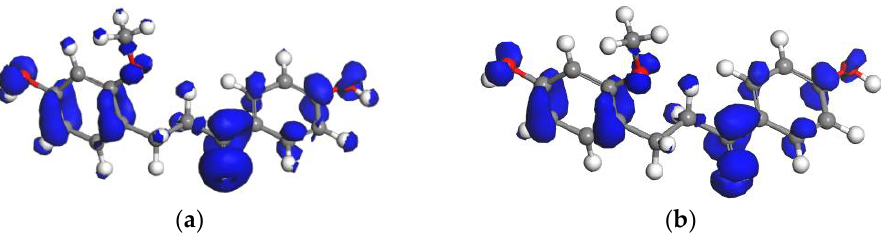
Figure 4. The Fukui function f 0 ( r ) of LC in gas phase ( a ) and in water ( b ) (mapped onto the isosurface of the total electron density, isovalue = 0.012507 a.u.). Table 2. The Fukui indices 𝑓 𝑘0 of atoms of LC in gas phase and in water (atomic labels in LC, see Figure 3c).